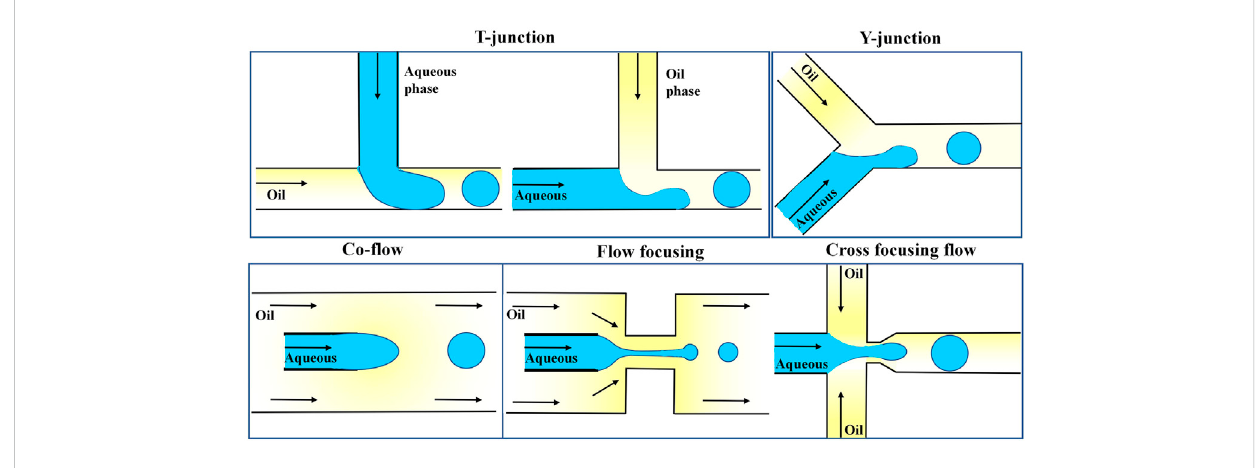
FIGURE 2 Different channel designs for droplet generation (T, Y, co- fl ow, fl ow focusing, and cross-focusing fl ow) (Vladisavljevic et al.,